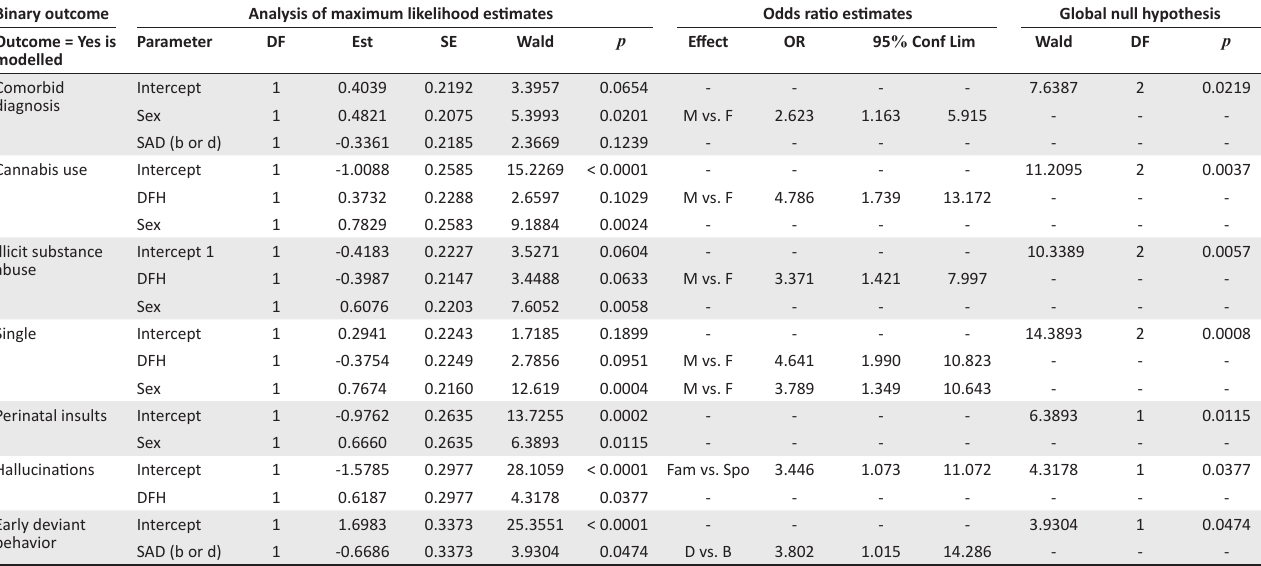
TABLE 2-A1: Logit models where predictors entered are DFH, sex, schizoaffective disorder (bipolar or depressive). Binary outcome Analysis of maximum likelihood estimates